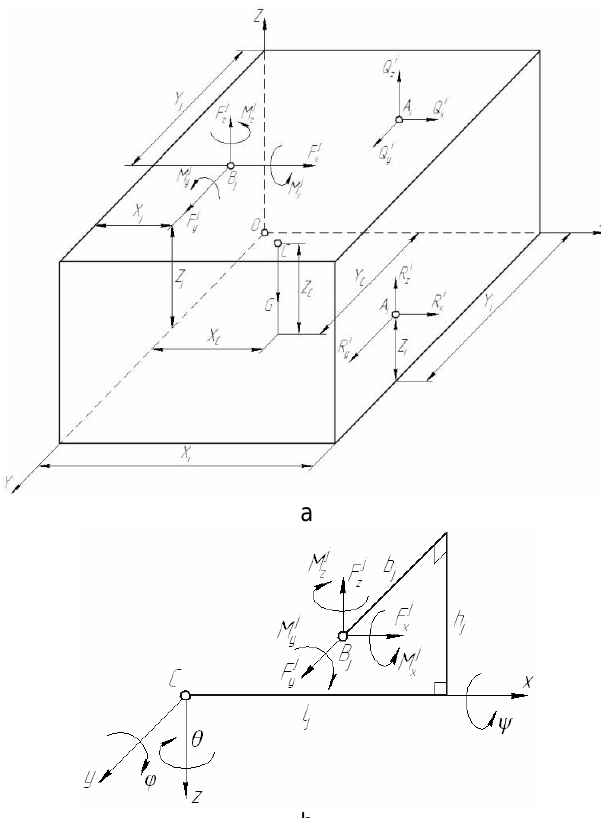
Figure 2. Calculation scheme (а) and the system of dynamic components of cutting forces (b)